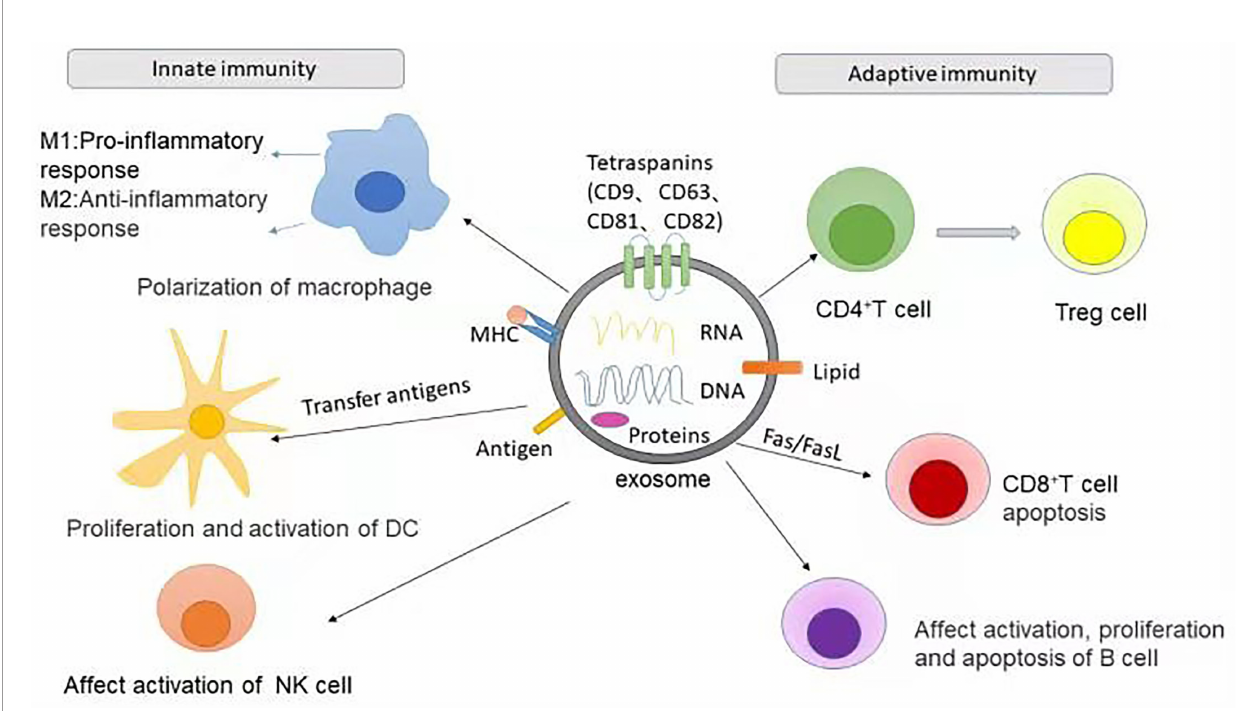
FIGURE 1 | The role of exosomes in two types of immunity. In innate immunity, exosomes can promote the polarization of macrophages to M1 or M2 types, respectively leading to the promotion or inhibition of in fl ammatory response. The MHC complex and antigens carried by exosomes can present the antigen complex to DCs, thereby promoting the proliferation and activation of DCs. Exosomes can also activate NK cells or inhibit the cytotoxic activity of NK cells. The role of exosomes in adaptive immunity is to in fl uence the activation, proliferation and apoptosis of T cells and B cells. For example, MSCs-derived exosomes can promote the differentiation of CD4+T cells into Treg cells and CD8+T